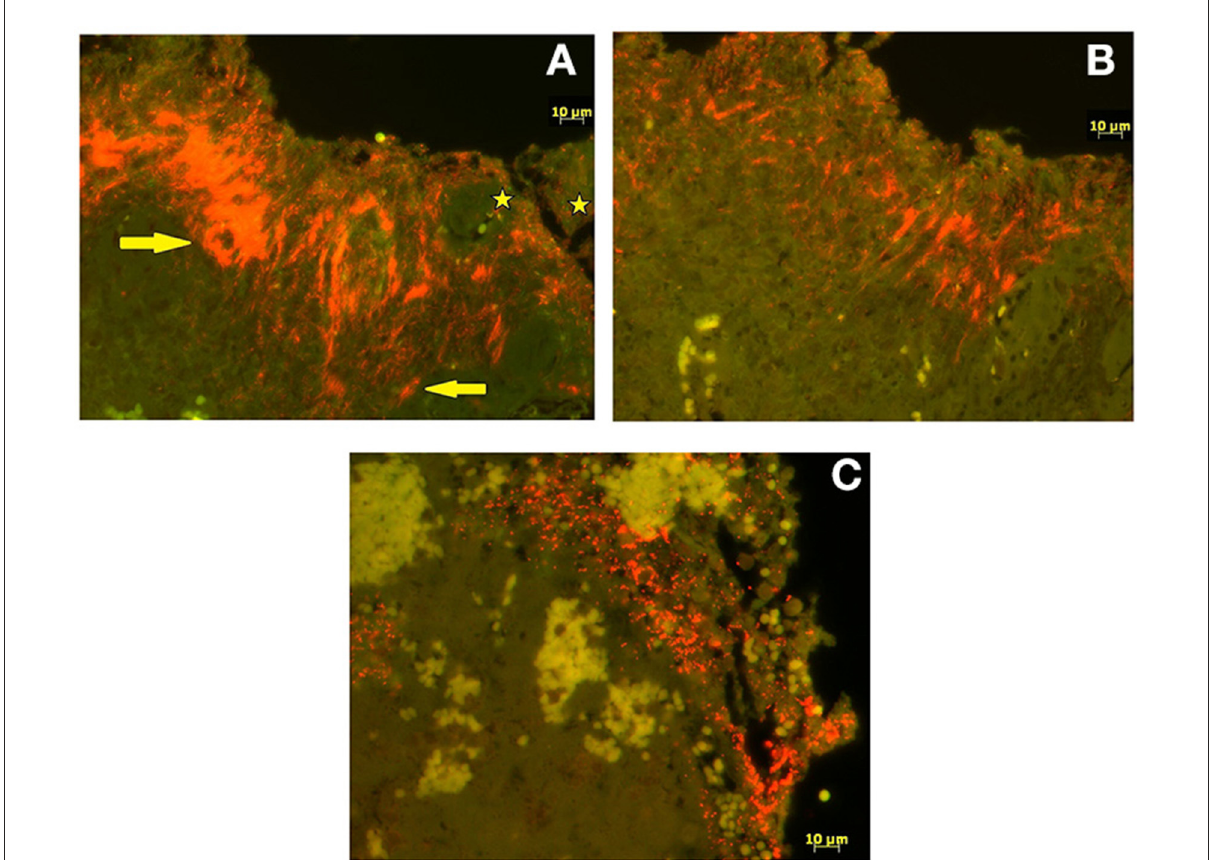
FIGURE3 Fluorescent in situ hybridization. (A) Double fluorescent in situ hybridization with probe for genus Treponema (Cy3 labeled; orange) and for domain Bacterium (fluorescein labeled; bright green). Treponema organisms (arrows) infiltrating deep into the epidermis whereas other bacteria (stars) are seen superficially. (B) Single fluorescent in situ hybridization (Cy3 labeled; orange) for species specific oligonucleotide probes for Treponema pedis . (C) Single fluorescent in situ hybridization (Cy3 labeled; orange) for species specific oligonucleotide probes for Porphyromonas levii